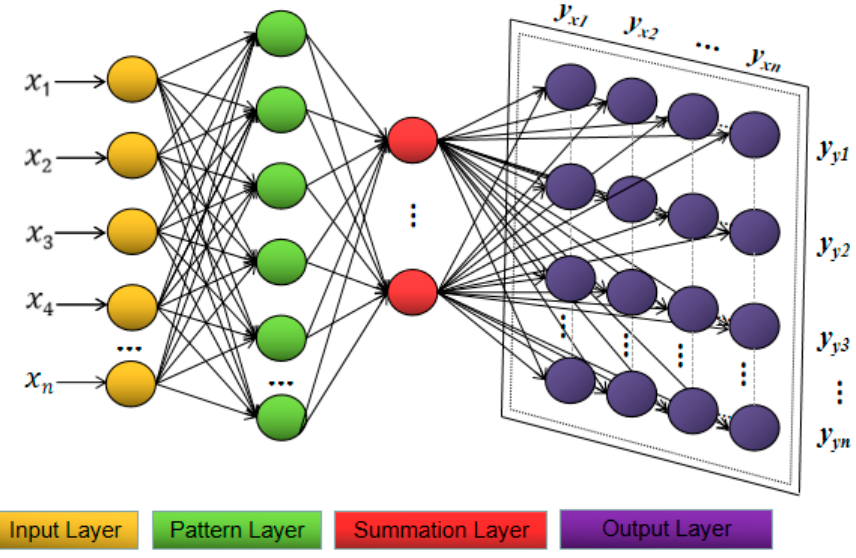
Figure 1. Network structure.